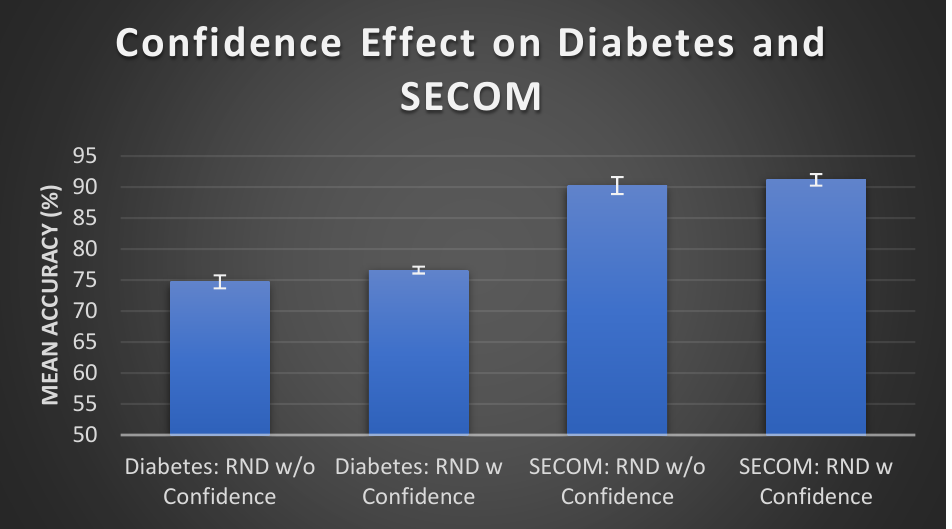
Figure 5. Mean accuracy with standard deviation bars of AutoDT on Diabetes and SECOM datasets.